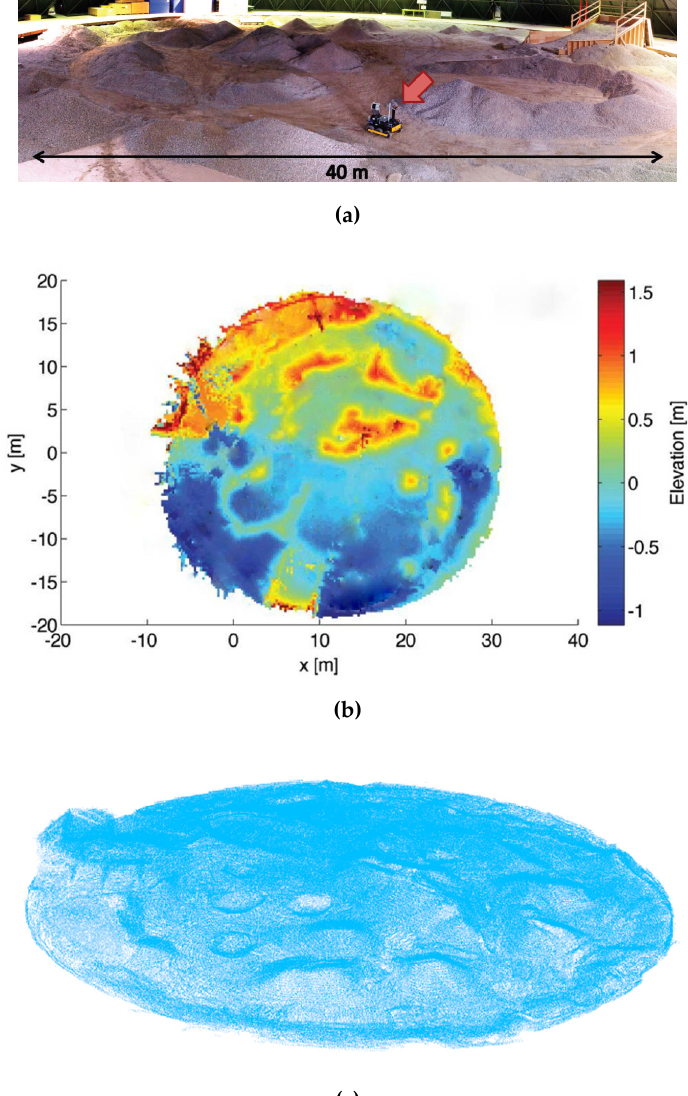
Figure 10. The unstructured terrain 3D mapping dataset. ( a ) Original picture of the unstructured terrain; ( b ) depth image of the unstructured terrain; ( c ) point cloud of the unstructured terrain (914608 points).